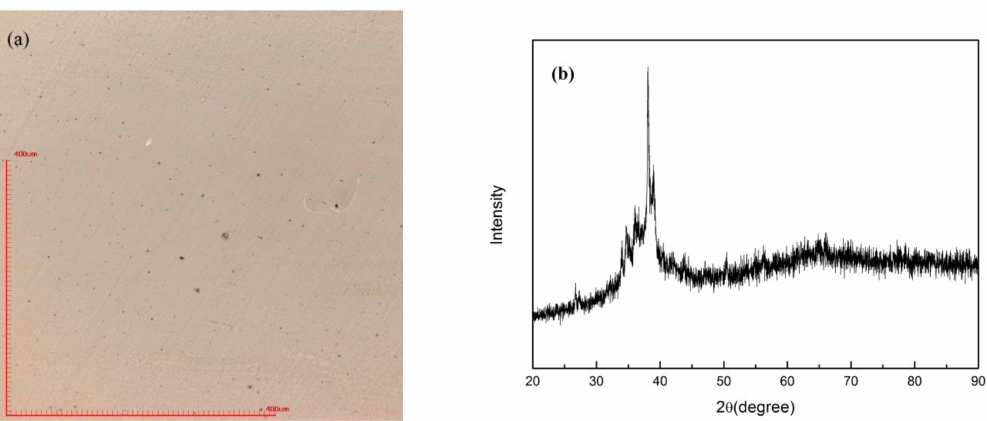
Figure 7. SLM specimen (P = 160 W, t = 60 µ s) fabricated by re-melt scanning strategy. ( a ) optical microscope image; ( b ) XRD pattern.